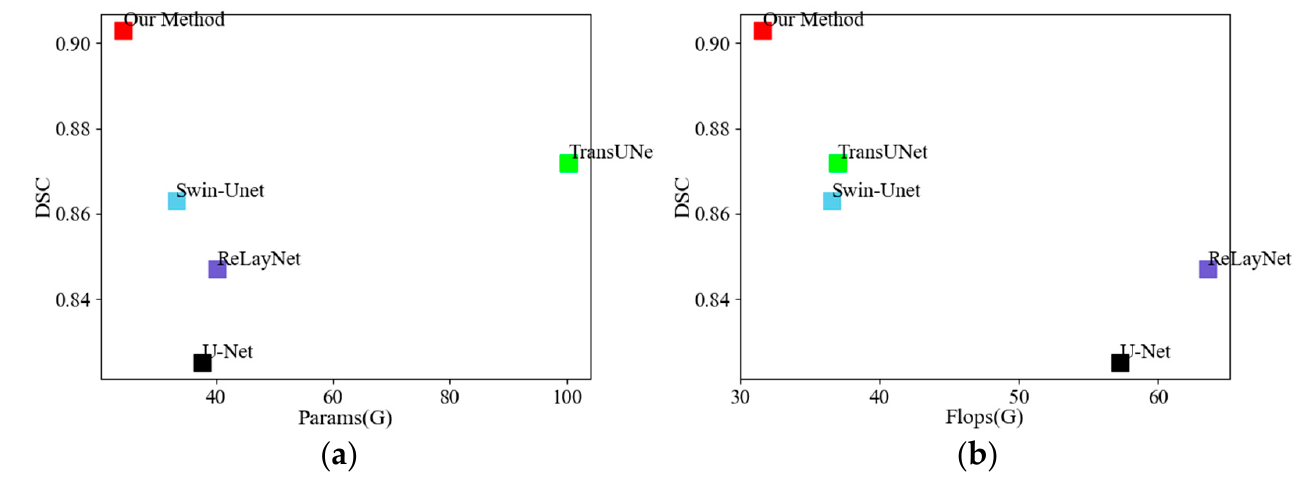
Figure 10. Comparison of different models: ( a ) Comparison of the number of parameters; ( b ) comparison of the amount of calculation.